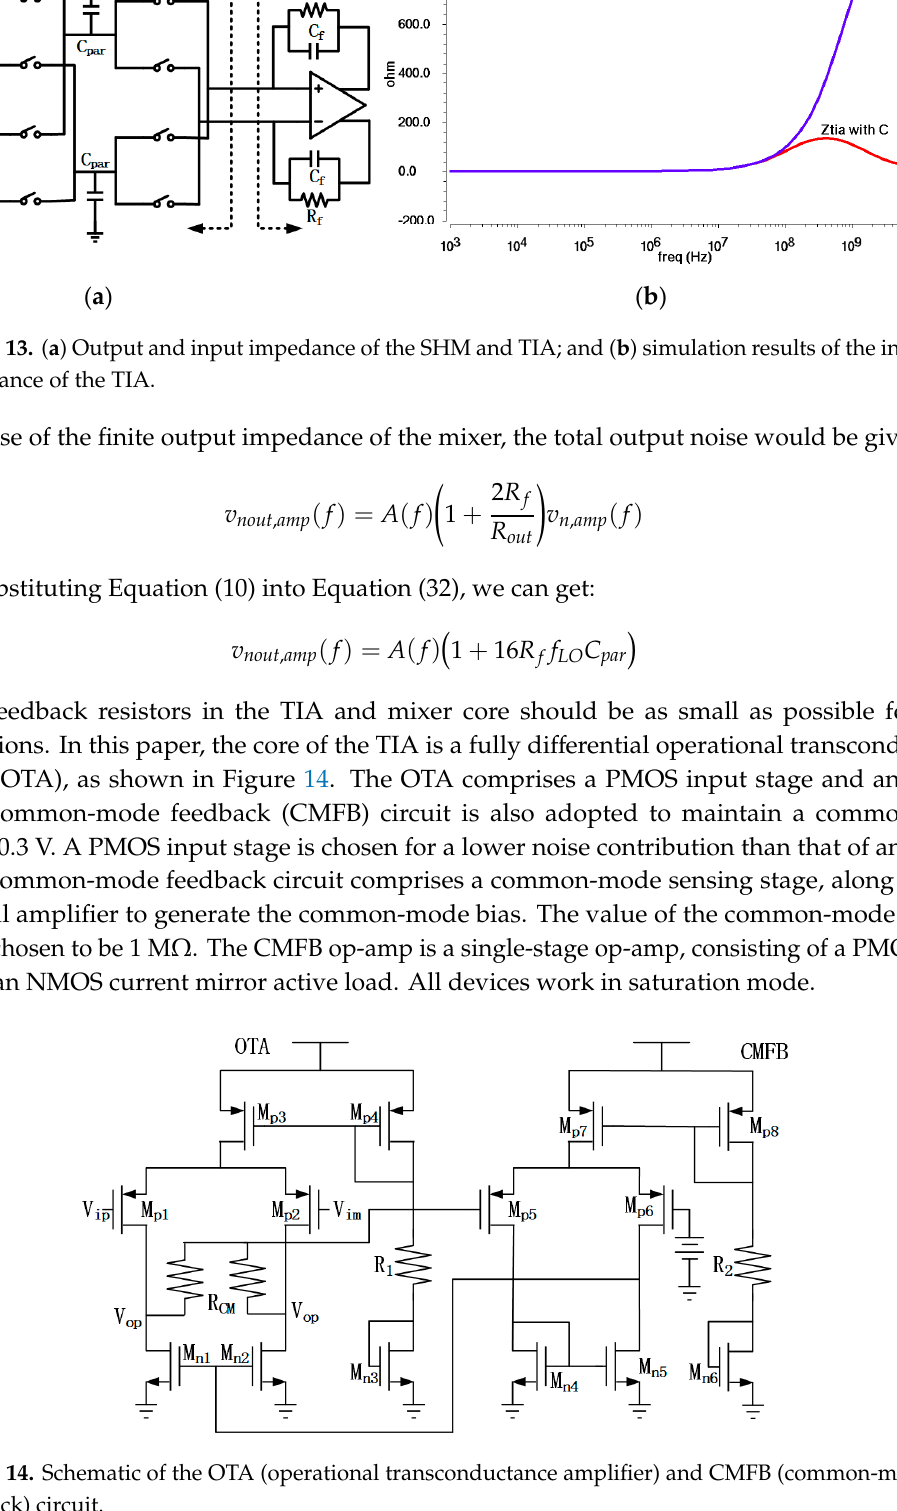
feedback) circuit. feedback)